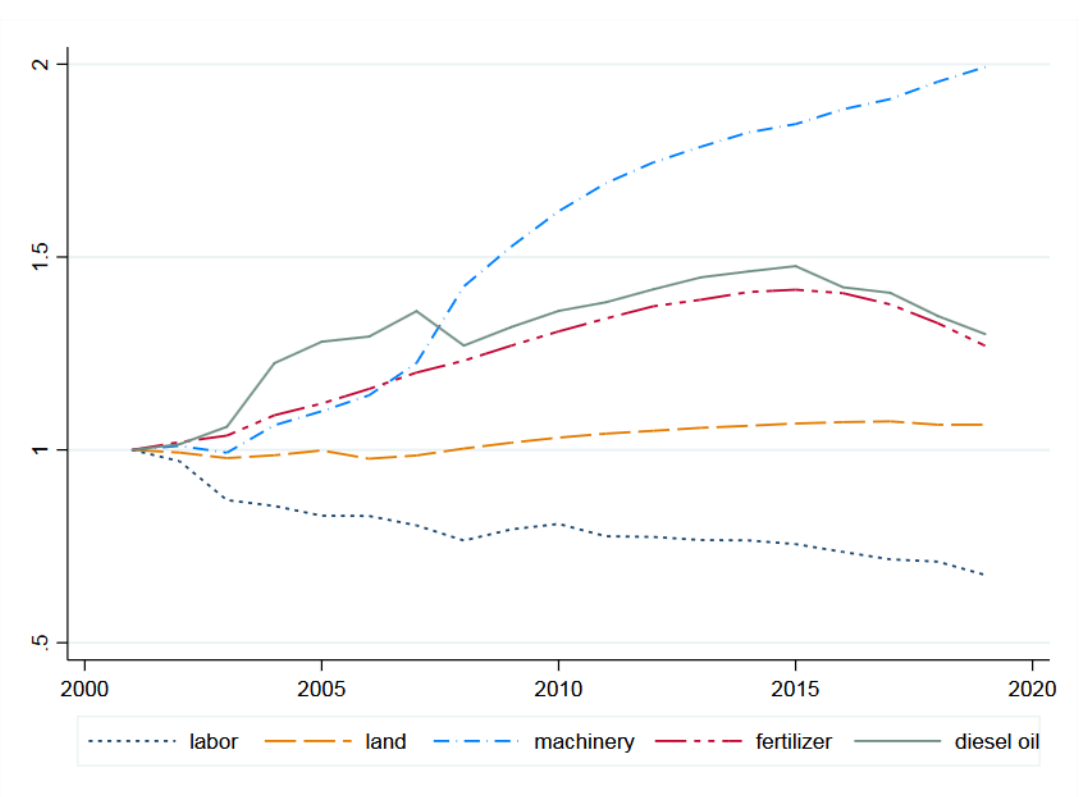
Figure 3. Change rate of planting outputs from 2001 to 2019.